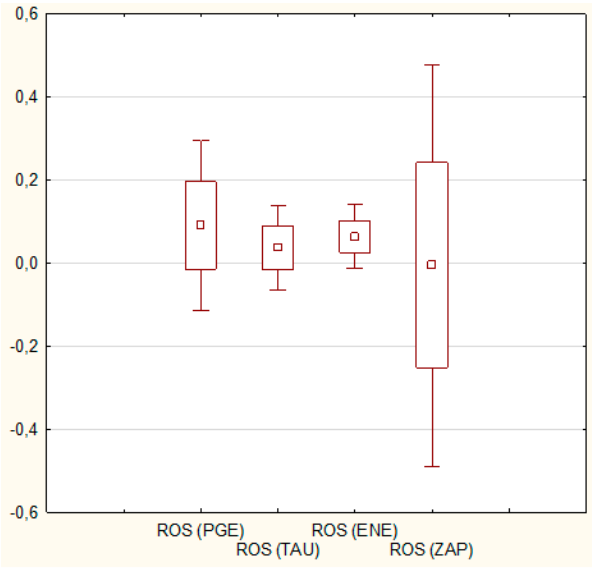
Figure 10. Box plot for ROS Source: Own elaboration.